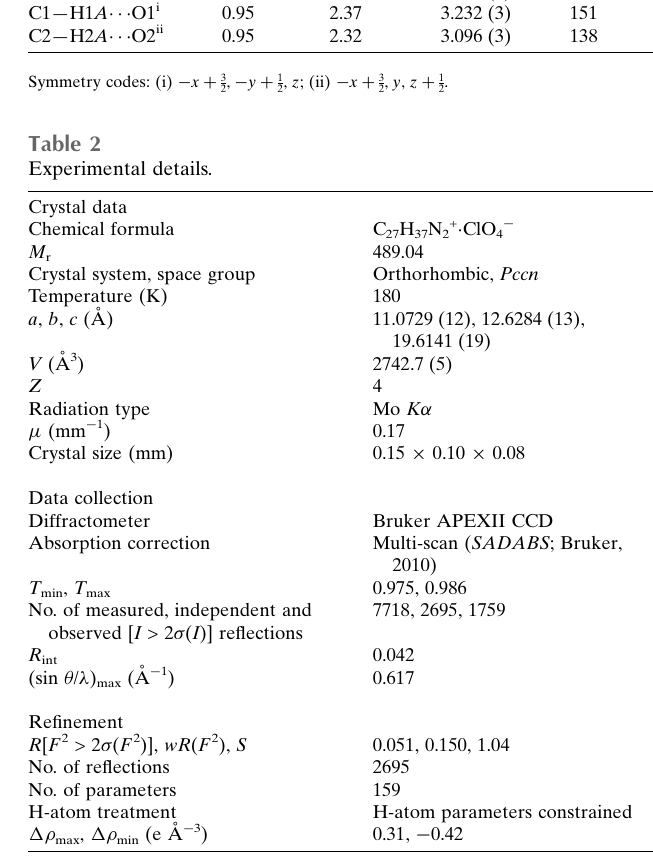
Computer programs: APEX2 and SAINT (Bruker, 2010), SHELXT2018/1 (Sheldrick, 2015 a ), SHELXL2018/1 (Sheldrick, 2015 b ) and SHELXTL (Sheldrick, 2008).